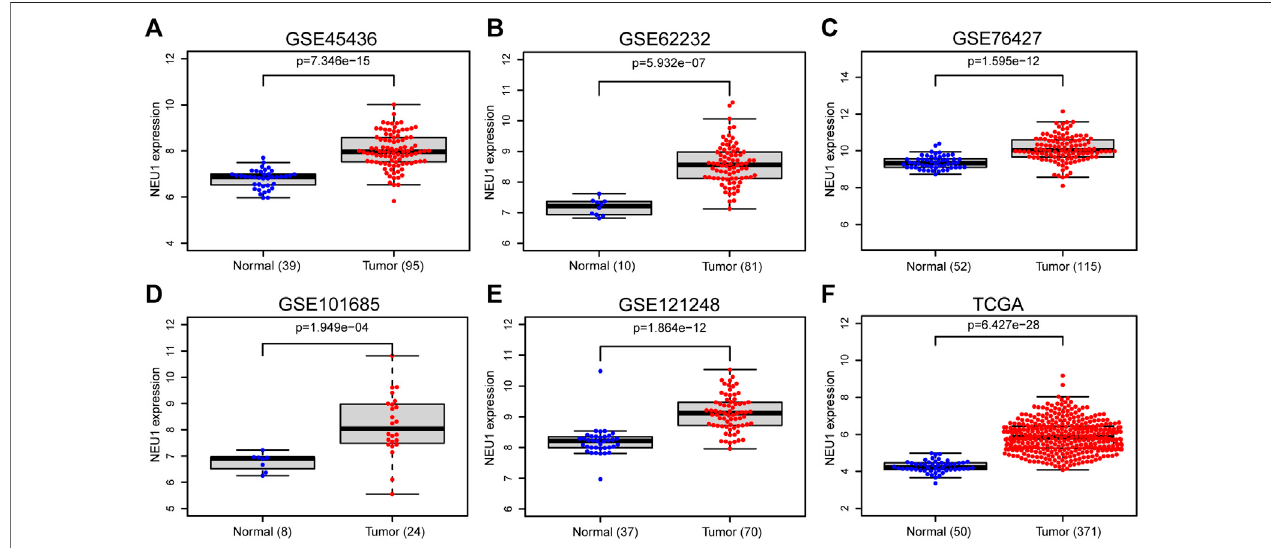
FIGURE2| ExpressionofNEU1inHCCandnormaltissues(TCGAandGEOdatasets) (A) GSE45436dataset; (B) GSE62232dataset; (C) GSE76427dataset; (D) GSE101685 dataset; (E) GSE121248 dataset; (F) TCGA dataset.